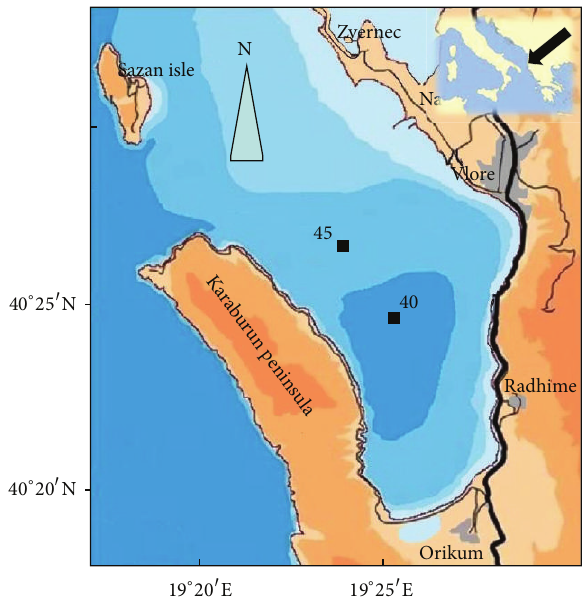
Figure 1: Map of study area showing location of two sampling stations (40, 45) in Bay of Vlor¨e